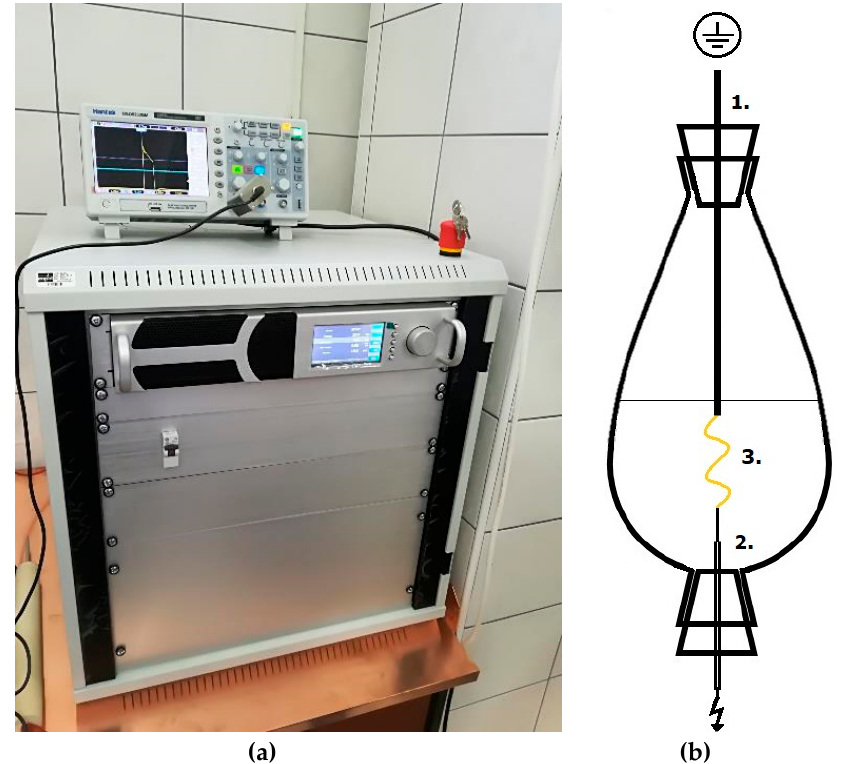
Figure 7. Set-up of generator and reactor for HVED treatments: ( a ) HVED and plasma generator „IMP-SSPG-1200” (Impel group d.o.o., Zagreb, Croatia); ( b ) Beaker shaped reactor: (1)—ground electrode; (2)—high voltage electrode (needle with empty interior for argon and nitrogen flow) during treatments; and (3)—discharge (plasma).